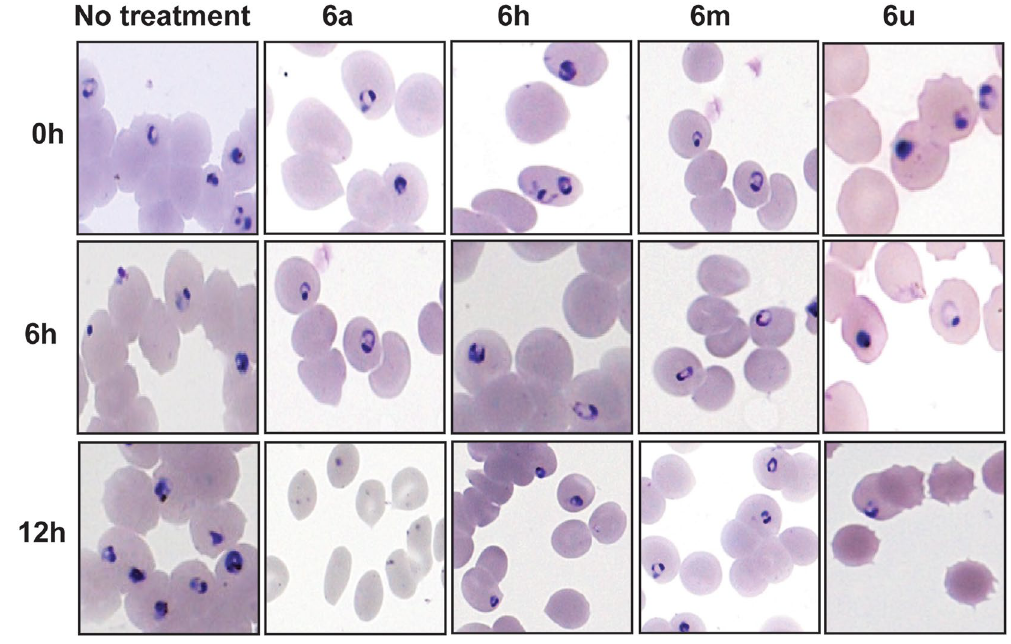
Figure 3. Micrographs of P. falciparum ring-stage forms treated with Pht analogues. Illustration of Pht analogues treatment effect on early erythrocytic parasite stage (rings). (All treatments were performed in parallel to a no treatment group).